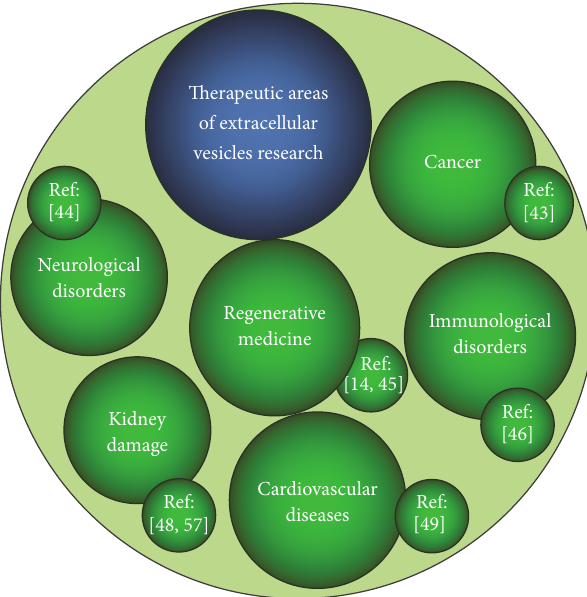
Figure 1: Main areas of potential therapeutic use of mesenchymal stem/stromal cells-derived extracellular